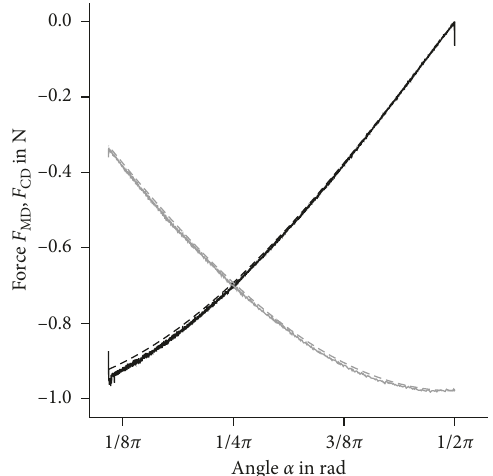
Figure 5: Plot of the measured forces with respect to the feed distance over 600mm path at 100g weight. In black is F MD and in grey F CD . The solid lines represent the measured forces and the dotted lines represent the calculated For each combination of wire diameter and oblique angle, five repetitions of the test are performed and a cor- rection curve is derived. Using the curve, the true position of